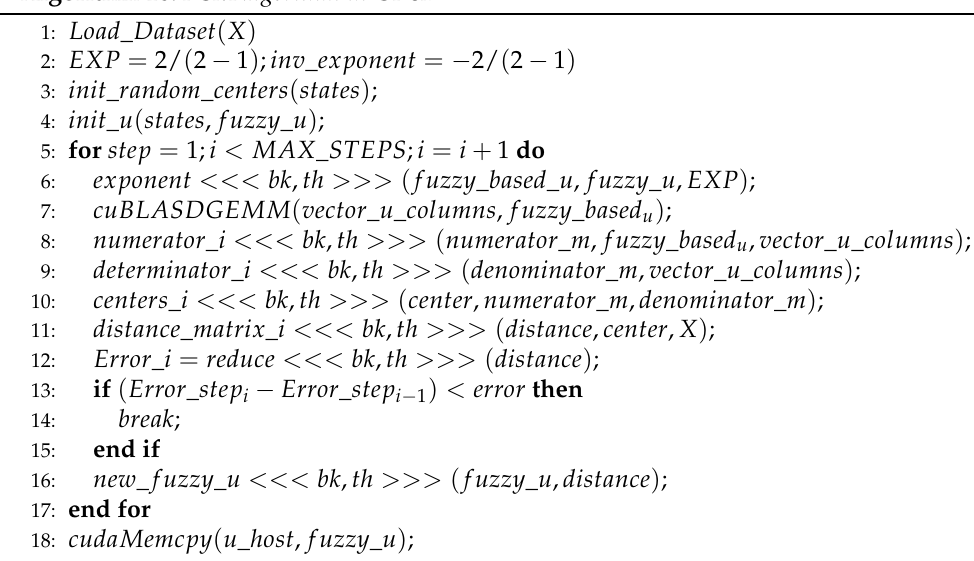
Algorithm 10: FCM algorithm in